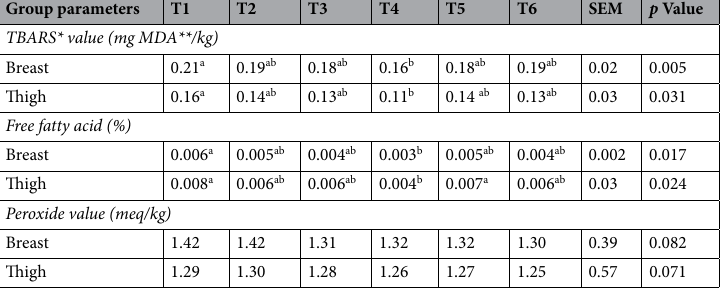
Table 4. Effects of dietary inclusion of prebiotics on lipid oxidation parameter of fresh meat in broiler chickens. T1 (no MOS/FOS/BMD), T2 (0.002% BMD), T3 (T1 + 0.1% MOS), T4 (T1 + 0.2% MOS), T5 (T1 + 0.1% FOS), T6 (T1 + 0.2% FOS). Mean values bearing the same superscript in a row did not differ significantly ( p < 0.05). *TBRS = 2-Thiobarbituric acid reacting substances; MDA** = Malondialdehyd. SEM = Standard error of mean; NS = Non-significant; n =